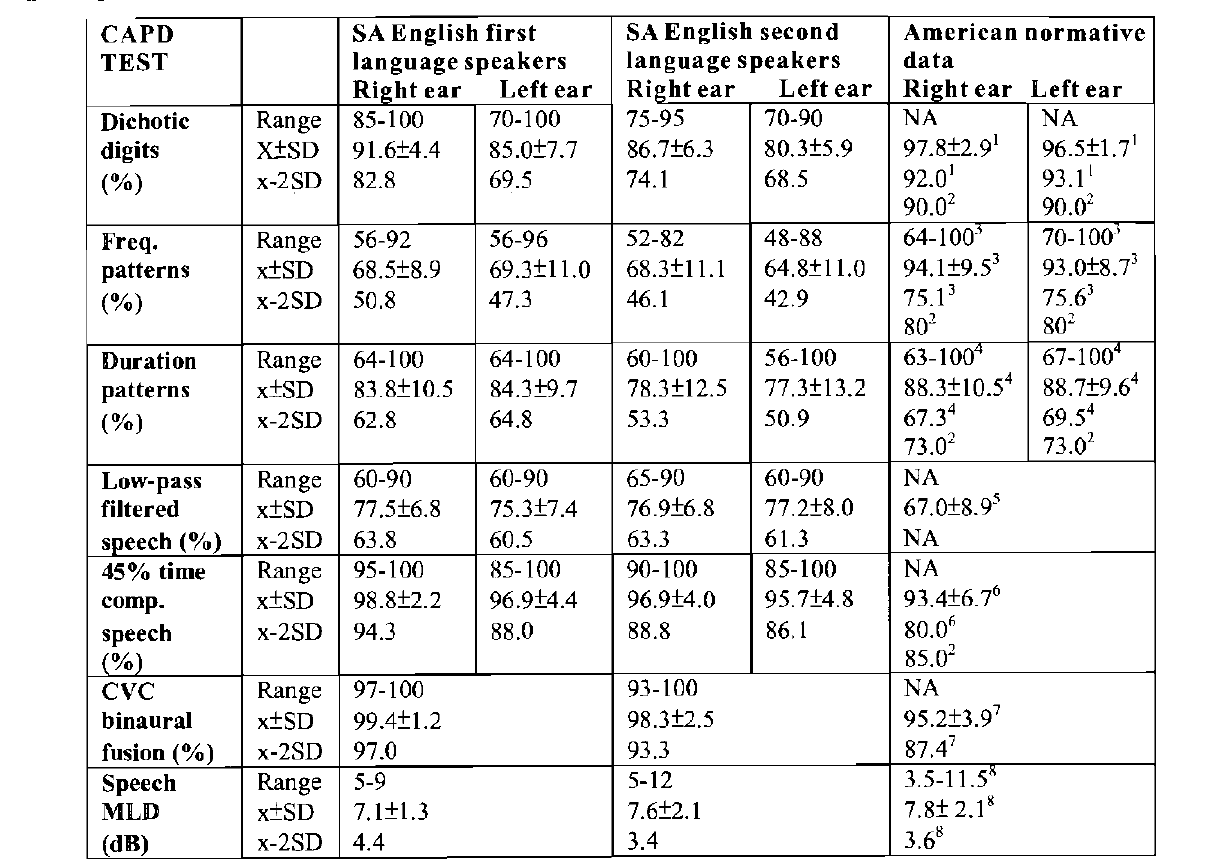
Table 1. CAPD test results for the adult, SA English first (n=16) and second (n=16) language speakers. All SA English speaker data was obtained at 50 dBSL relative to either 1000 Hz or spondee threshold.